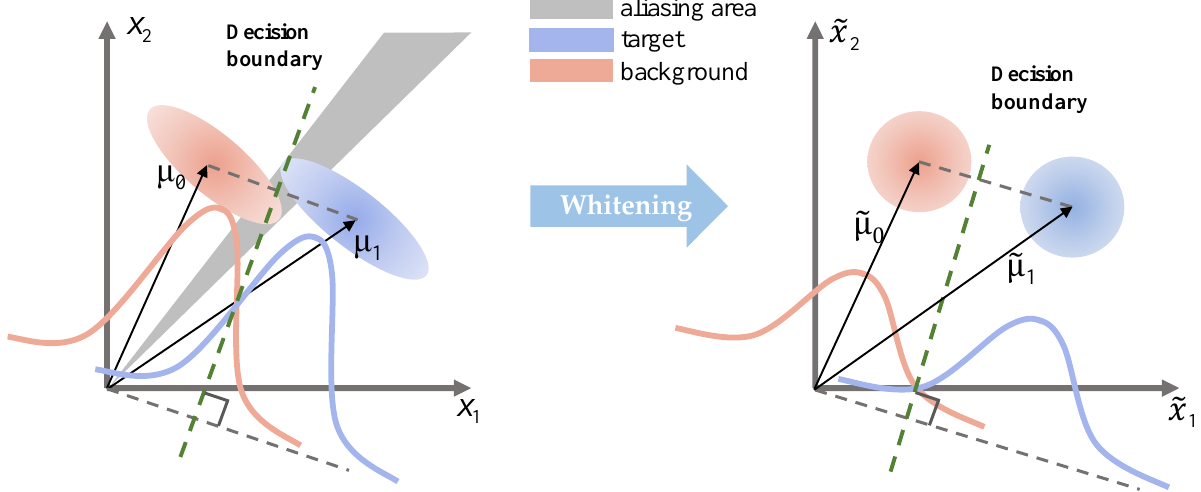
Figure 2. The original spectral observation space is shown at the left, and the whitened space with spherical covariance, created by the whitening transformation, is shown at the right. µ 0 and µ 1 represent the background and the target in the original spectral observation space, respectively. (cid:101) µ 0 and (cid:101) µ 1 represent the background and the target in whitened space, respectively. There is an aliasing area in the original spectral observation space. Both the target and background are considered as Gaussian distribution. The green dotted line works as a decision boundary.